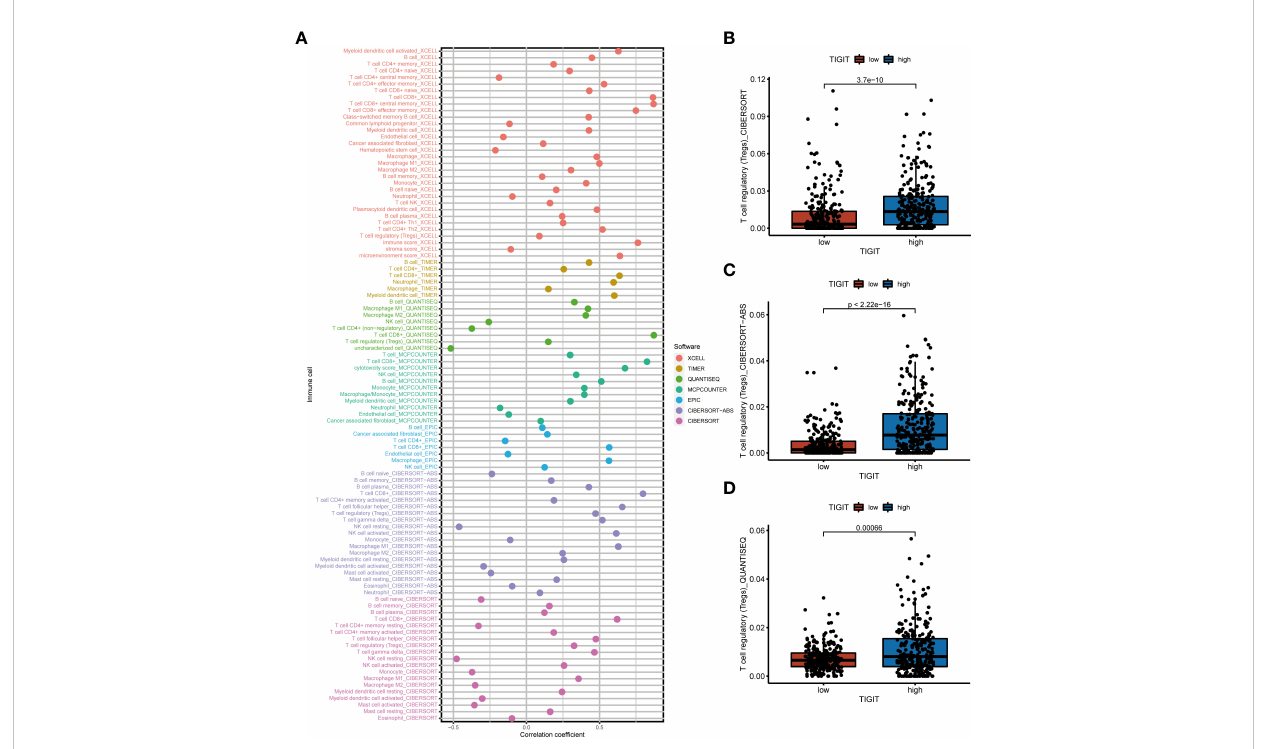
FIGURE 7 The correlation between immune in fi ltration and the expression of TIGIT in KIRC. (A) Spearman correlation test showed TIGIT was signi fi cantly associated with several types of immune in fi ltration cells. (B) Differential in fi ltration of Tregs between high or low TIGIT expression patients calculated by the CIBESORT. (C) Differential in fi ltration of Tregs between high or low TIGIT expression patients calculated by the CIBESORT-ABS. (D) Differential in fi ltration of Tregs between high or low TIGIT expression patients calculated by the QUANTISEQ.